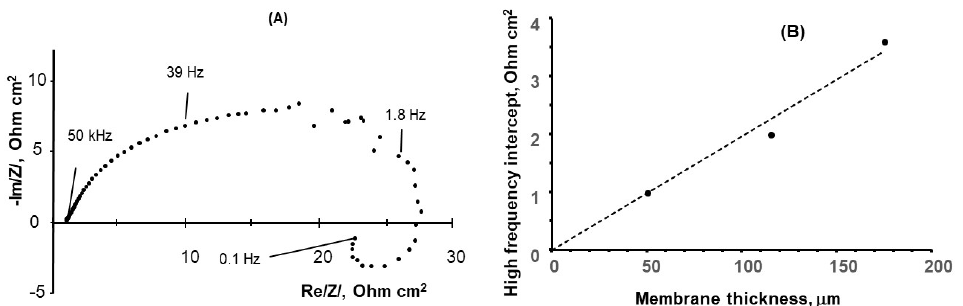
Figure 4. ( A ) Results of the EIS measurements at the open circuit voltage for the Al/NaBrO 3 flow cell with an NR212 membrane at 30 °C. The conditions are similar to those shown in Figure 1. ( B ) Dependence of the high frequency intercept at the Re/Z/ axis on the membrane thickness.